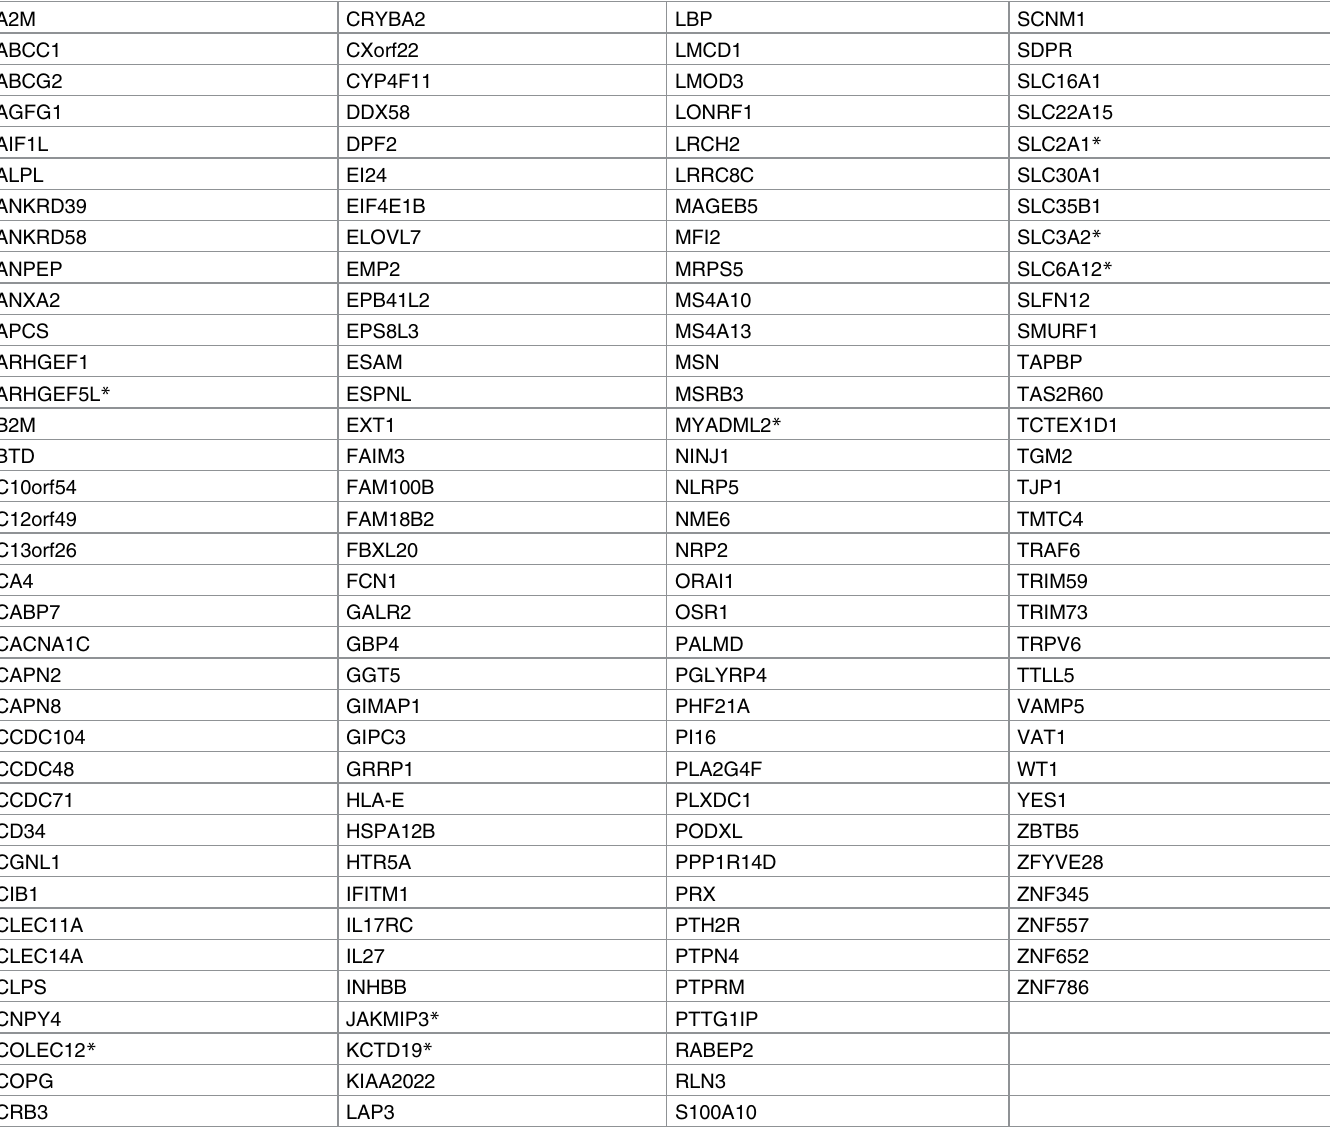
Table 1. Curated brain endothelial proteins from the Human Protein Atlas. Listed proteins(n = 140) were predicted to be expressedonly in brain endo- theliumbut not other cell types in the brain. A majority of these proteins are also expressedin non-cerebral smooth muscle.